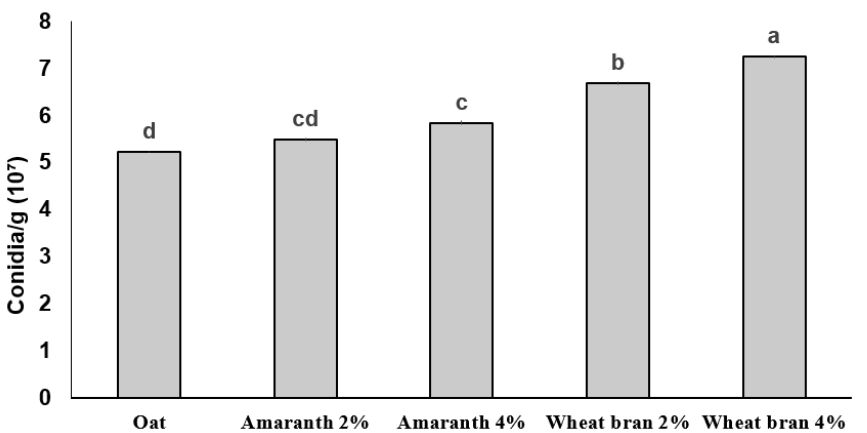
Figure 3. Hirsutella citriformis conidia production on oat grains. The Oat bar represents oat used as substrate or oat supplemented with amaranth or wheat brand at 2% and 4%. Fungi conidia produc- tion per gram of oat with or without different protein sources was evaluated at 14 d, as detailed in the text. Different letters indicate significant statistical differences, and bars indicate the standard error of the mean (Tukey test).